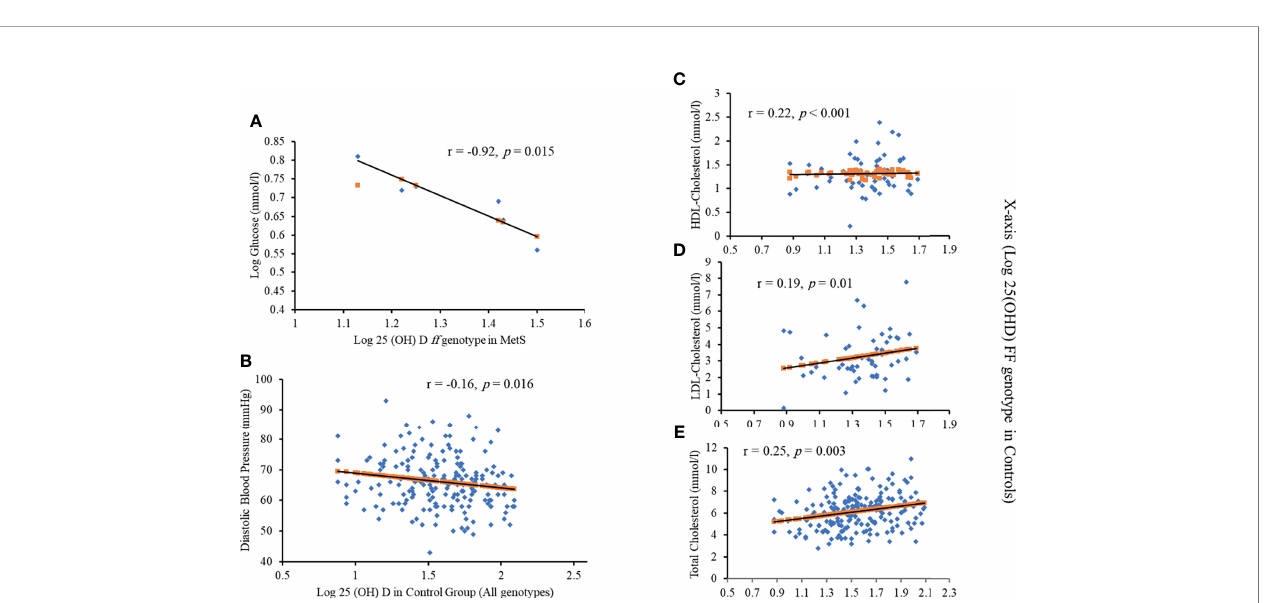
FIGURE 3 | Signi fi cant correlations between Log 25(OH)D and (A) Log glucose in ff genotype in MetS; (B) diastolic blood pressure in all genotypes; (C) HDL cholesterol in FF genotype in controls; (D) LDL cholesterol in FF genotype in controls and (E) Total cholesterol in FF genotype in